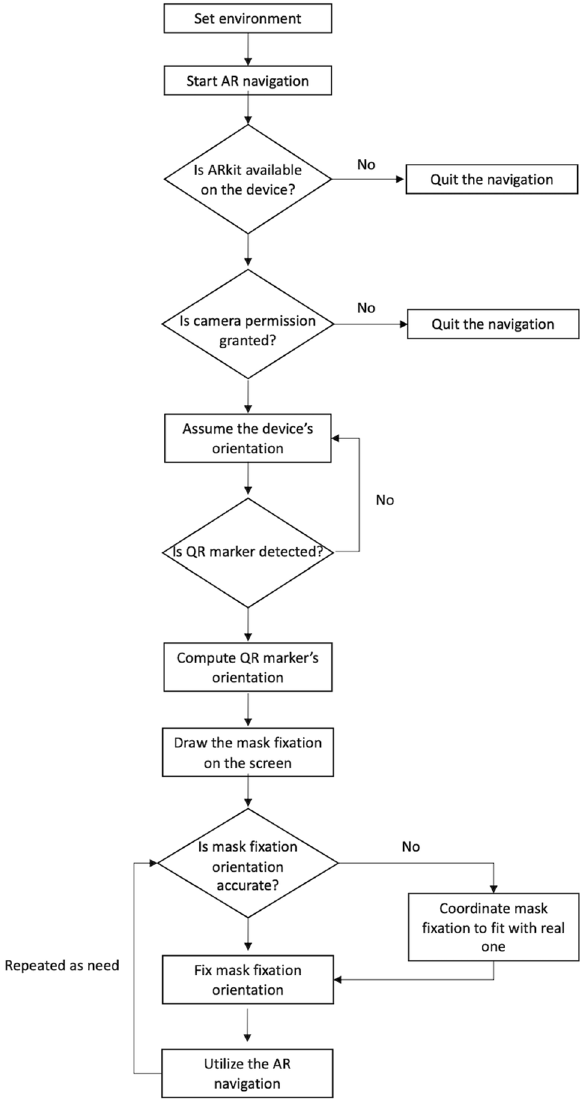
Figure 4. Workflow of the inside-out AR navigation algorithm and running